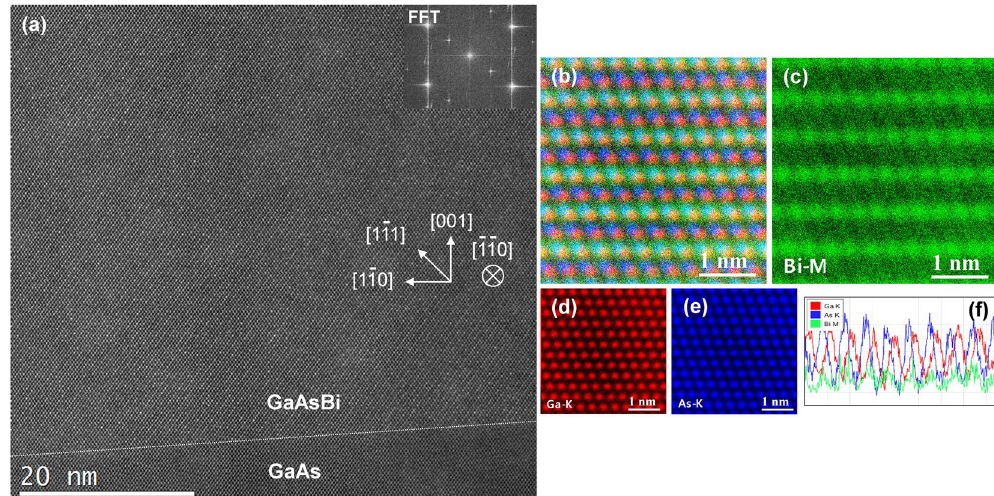
Figure 5. ( a ) HAADF image of single-variant CuPt-ordered bismide sample S2 near the interface with GaAs buffer layer. Crystallographic orientations and Fourier transform of the image are shown. ( b – e ) Atomic- resolution EDS images of the ordered bismide, with individual maps showing Bi, Ga, and As X-ray emissions, and their combined colour-overlaid map in ( b ). ( f ) Horizontally summed signal line-profile across an ordered Bi-rich (111) plane. Note that STEM scanning direction is set in the EDS to align ordered planes horizontally.